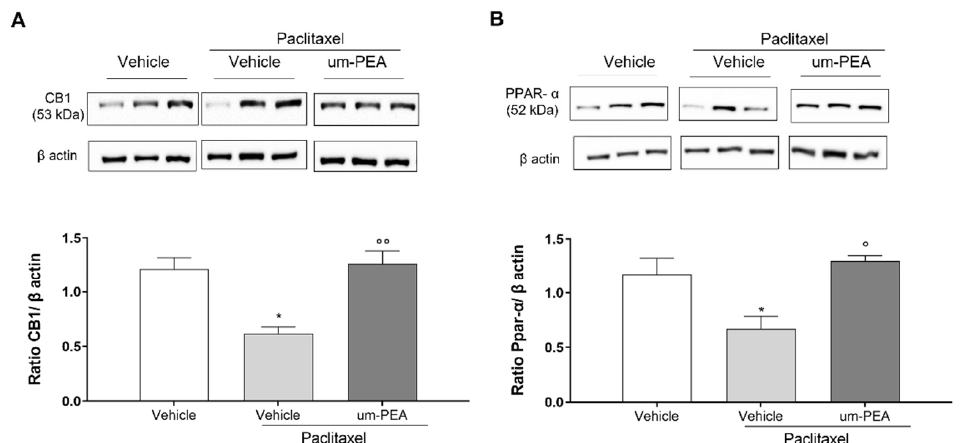
Figure 7. Western blotting analyses for CB1 ( A ) and PPAR- α ( B ) receptors in spinal cords. Im- munoblots representative of all tissues analyzed are shown. Densitometric analysis of protein bands are reported: the levels are expressed as the density ratio of target to control protein bands ( β -actin). * p < 0.05 versus vehicle group; ◦ p < 0.05 and ◦◦ p < 0.005 versus PTX group. Values are expressed as mean ± SEM ( n = 3). Differences were evaluated by ANOVA followed by Bonferroni’s post hoc test for multiple comparisons.